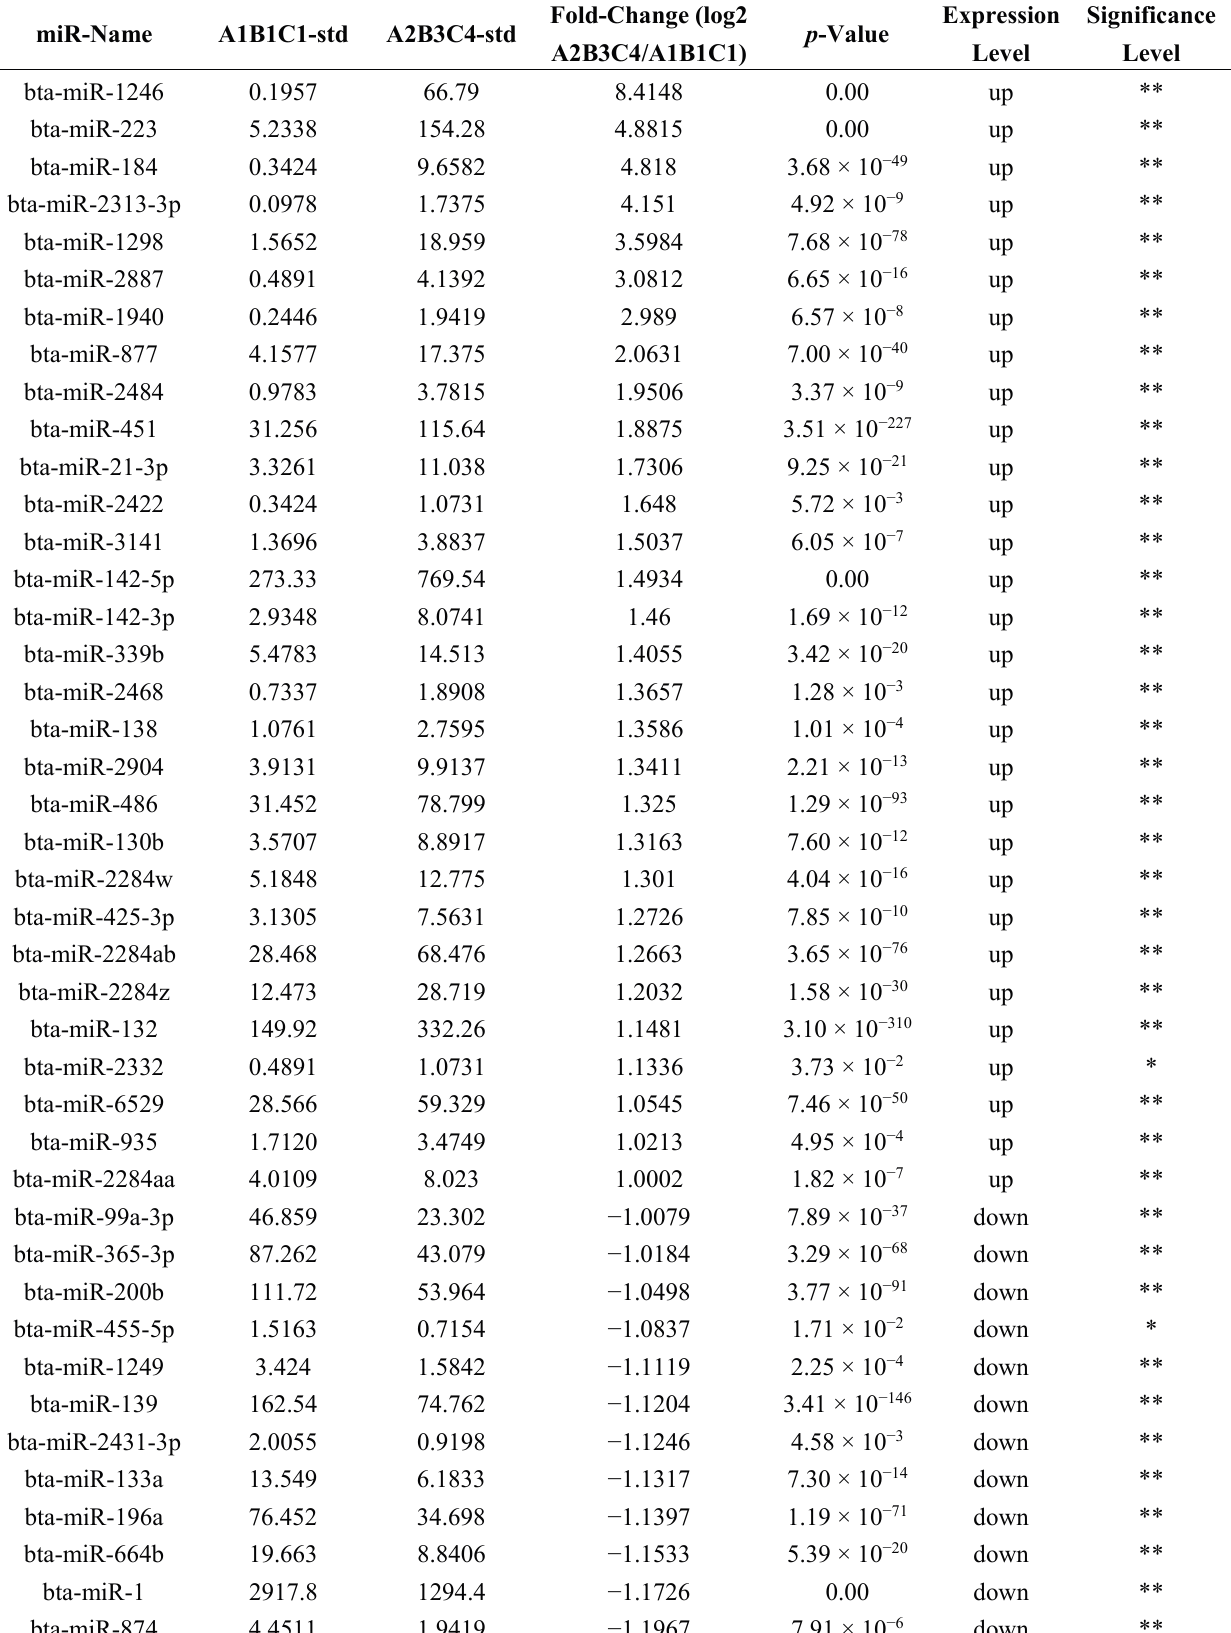
Table 1. Differential expression of known miRNAs in bovine mammary glands between the S. aureus and control groups. * p < 0.05, ** p <